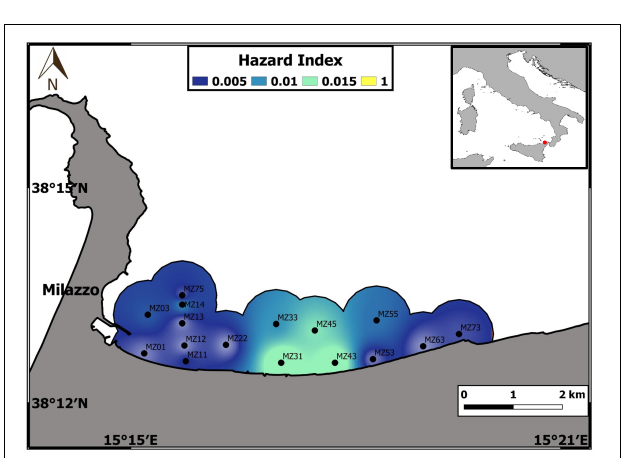
FIGURE 3 | Dermal Hazard Index distribution in the study area.